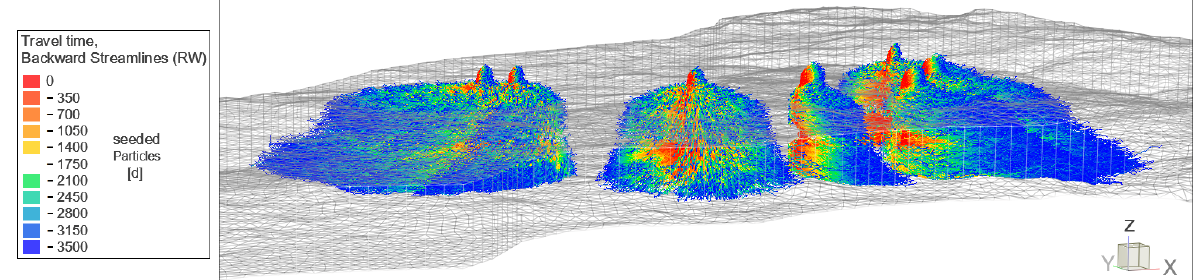
Figure 12. Using the particle tracker to calculate a catchment area for public wells in 3500 days.